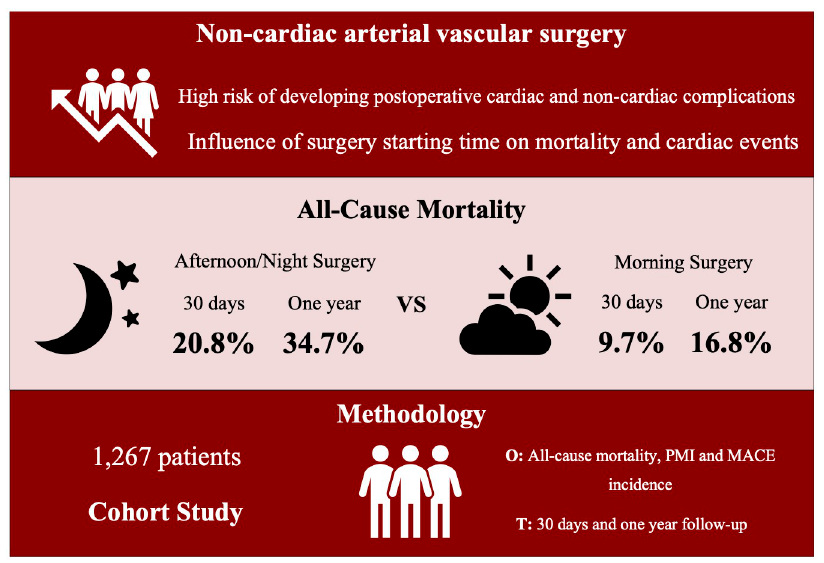
Fig 2. Graphical abstract. In patients submitted to arterial vascular surgery, being operated in the afternoon/night period was independently associated with increased mortality rates and higher incidence of PMI. O: outcomes. T: time of